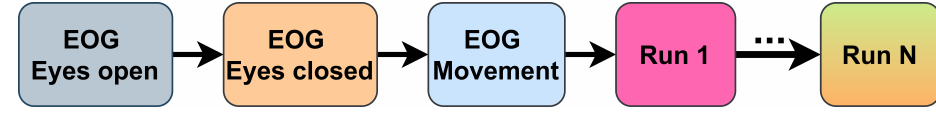
Figure 1. Experimental protocol for EEG recording.